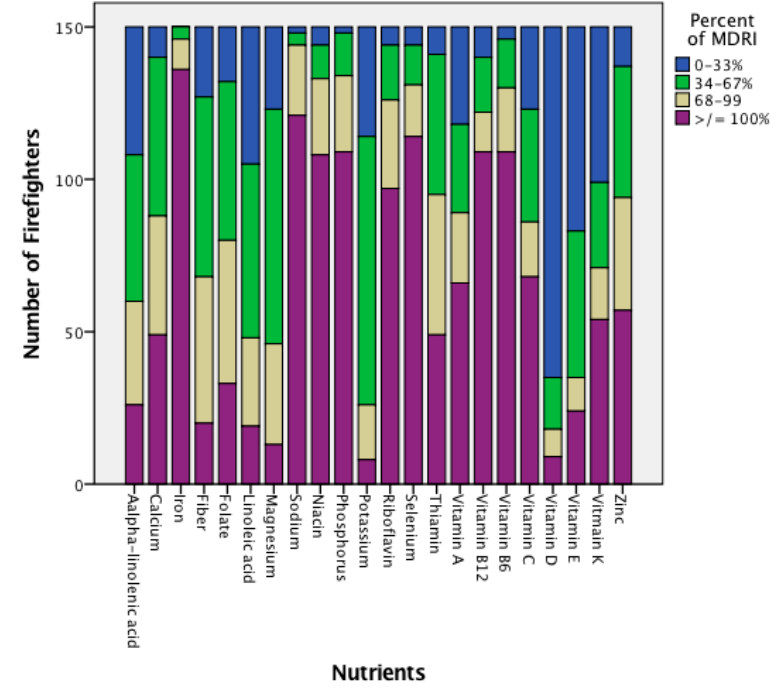
Figure 1. Categorized three-day average nutrient intake of firefighters compared to Military Dietary Reference Intake [5].